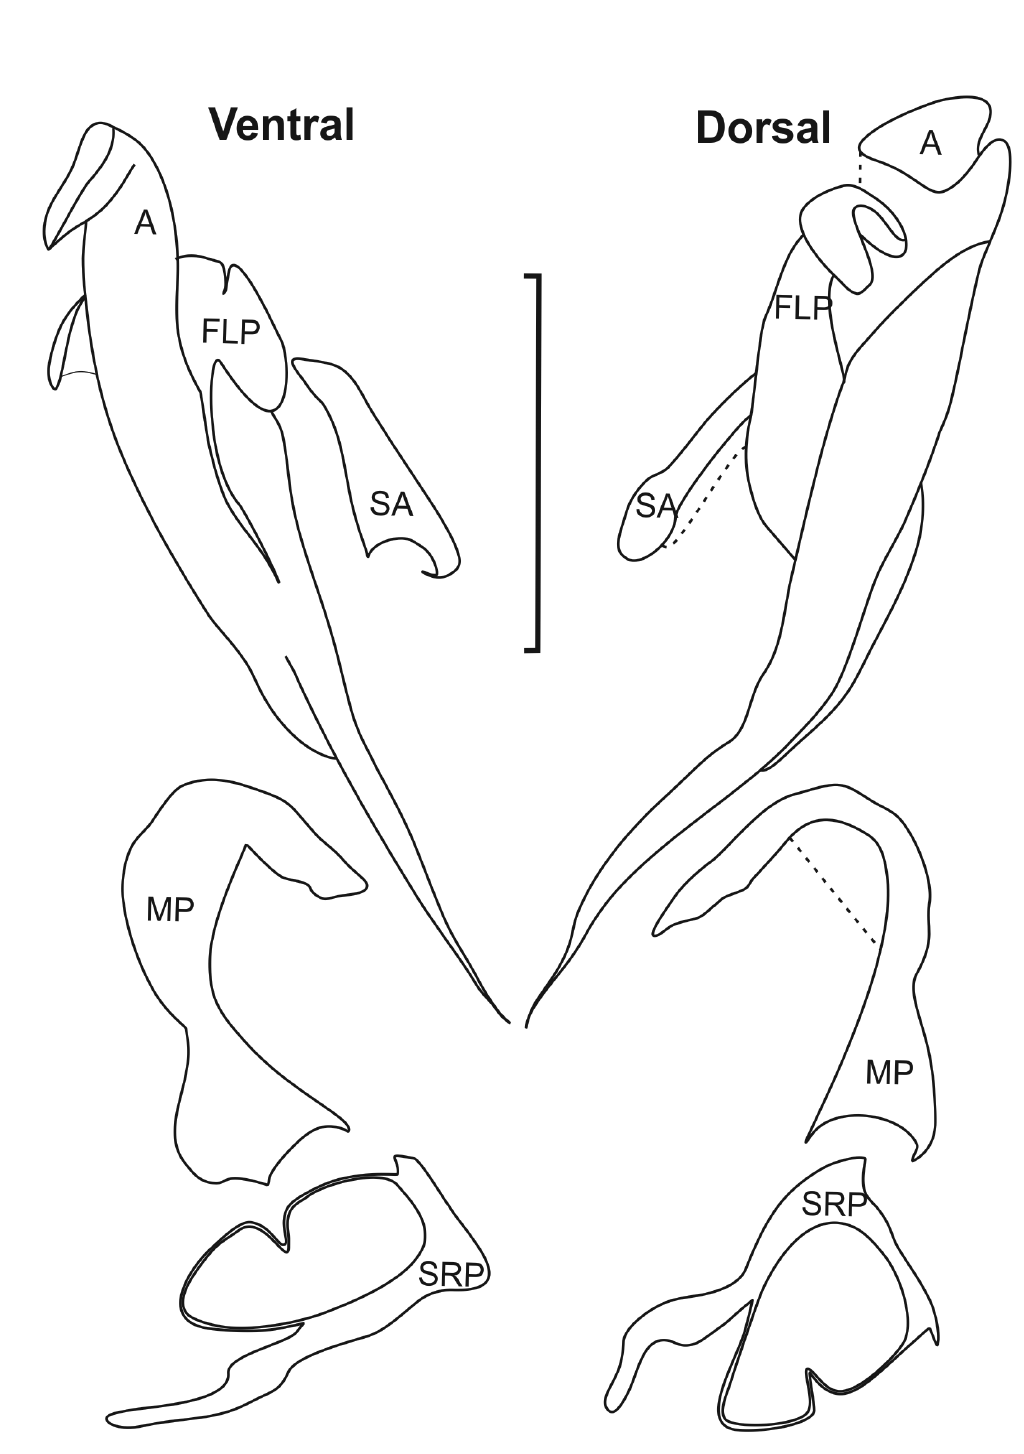
Fig. 7. Sclerites of the internal sac of Canthon (G.) fulgidus martinezi subsp. nov. Abbreviations: see Material and methods. Scale bar: